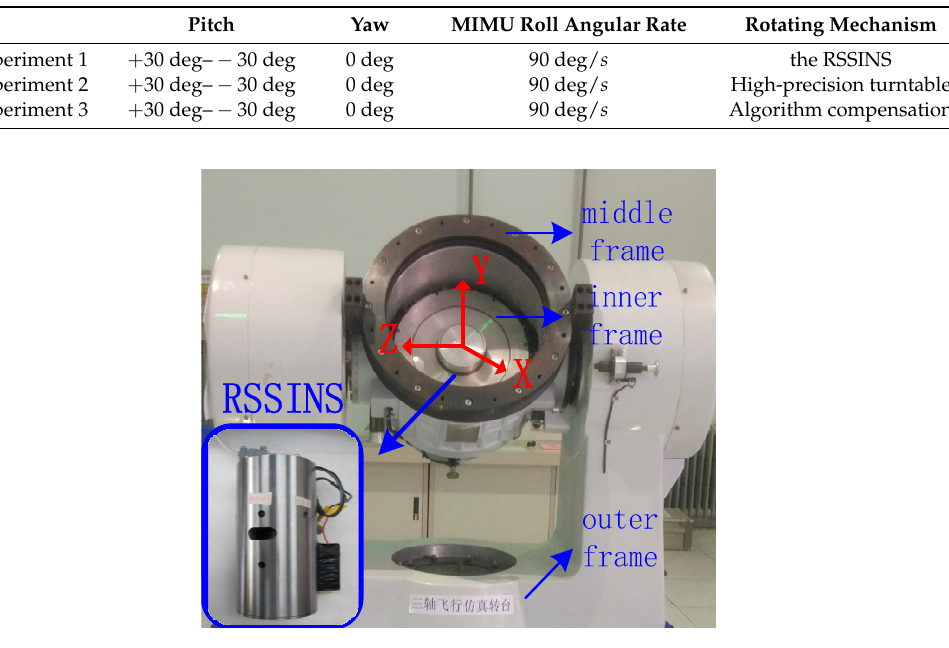
Figure 12. Modulation angular rate of Experiment 1 and Experiment 2.